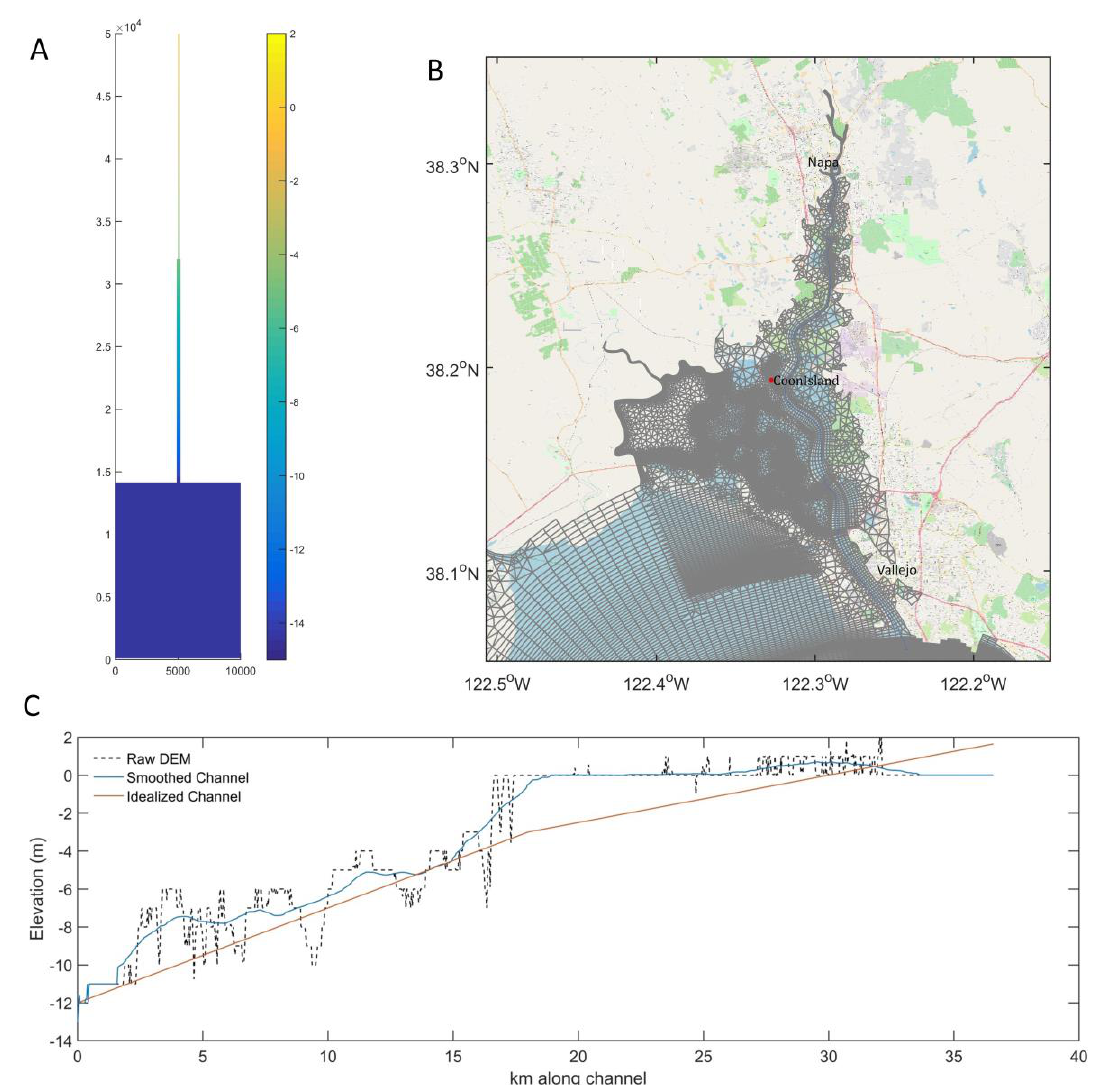
Figure 2. Comparison of the realistic field-scale and idealized models. ( A ) Birds-eye view of the idealized model grid colored by depth. ( B ) Realistic field-scale grid zoomed in on Napa, with the blue line showing the location of the river channel center. ( C ) Thalweg elevations of the Napa River channel (minimum elevations extracted from the digital elevation model and within 100 m of the channel center (dashed black line), smoothed elevations (blue solid line), and the idealized model grid (red dots)).